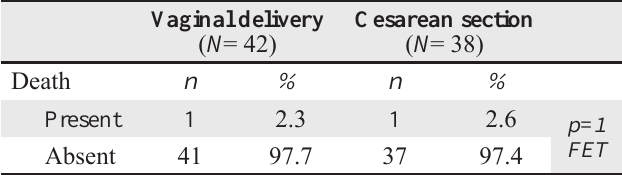
Table 3 : Perinatal mortality by mode of